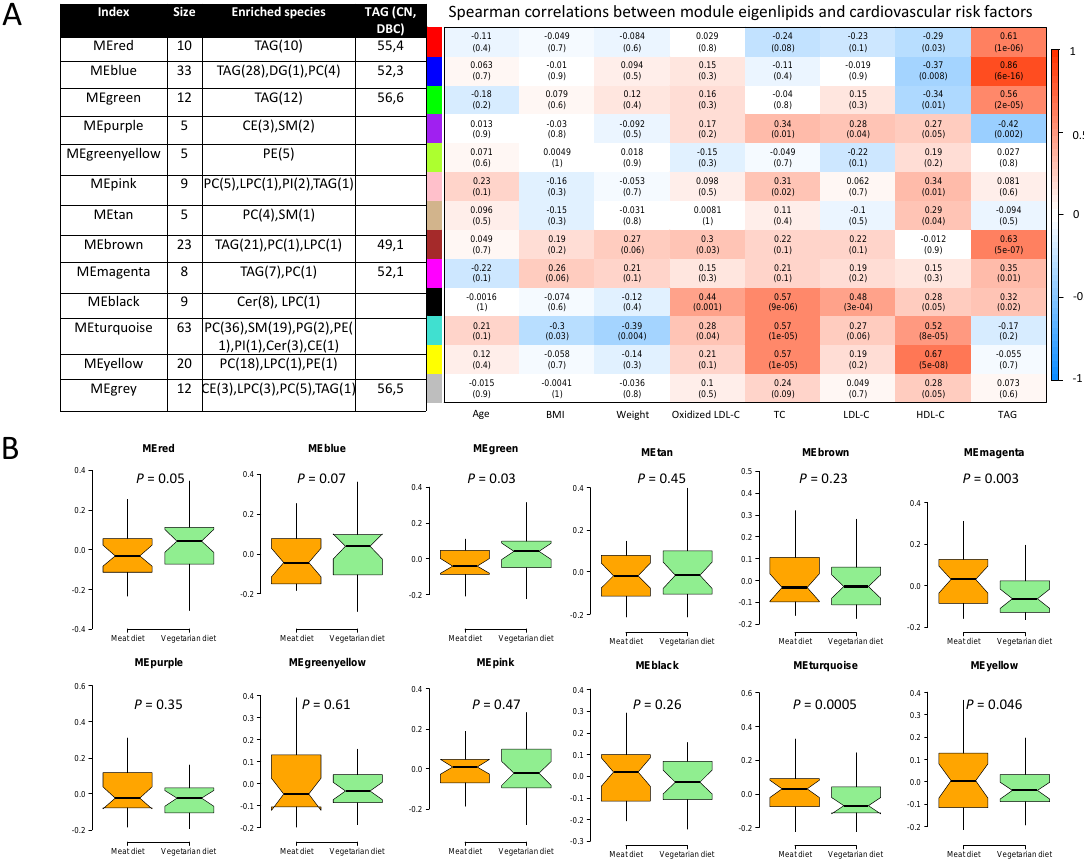
Figure 4. Co-expression modules of lipids determined by the weighted gene correlation network analysis. Module size, lipid species, and range of total number of carbons (CN) and number of double bonds (DBC) of TG ( A , right), Spearman’s correlation coe ffi cient between modules and cardiovascular risk factors ( A , left), and di ff erence in eigenlipid of modules between VD and MD ( B ). Cer, ceramide; CE, cholesteryl ester; DAG, diacylglyceride; HDL-C, High-density lipoprotein cholesterol; HexCer, hexosylceramide; LacCer, lactosylceramide; LDL-C, low-density lipoprotein cholesterol; LPC, lyso-phosphatidylcholine; O-PC, alkylphosphatidylcholines; PC, phosphatidylcholine; PE, phosphatidylethanolamine; PG, phosphatidylglycerol, PI, phosphatidylinositol; SM, sphingomyelin; TG,